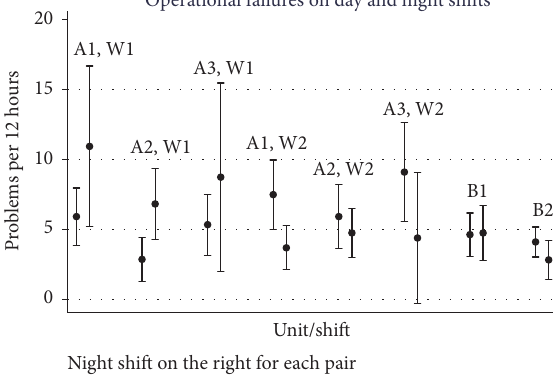
Figure 4: Rate of small operational failures by unit, disaggregated by day and night shifts, with estimate and 95%